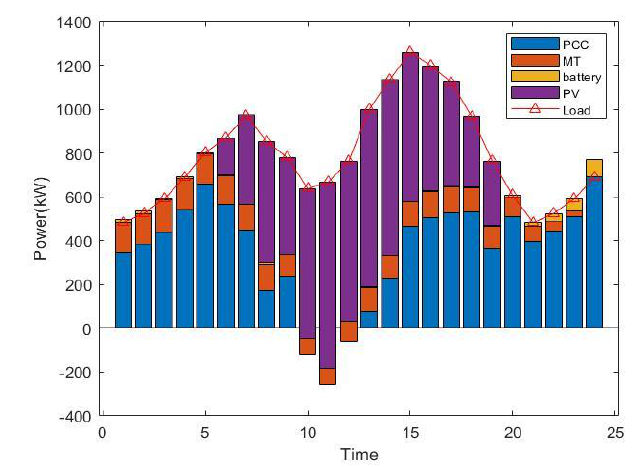
Figure 7. Optimal dispatch of DSO2.